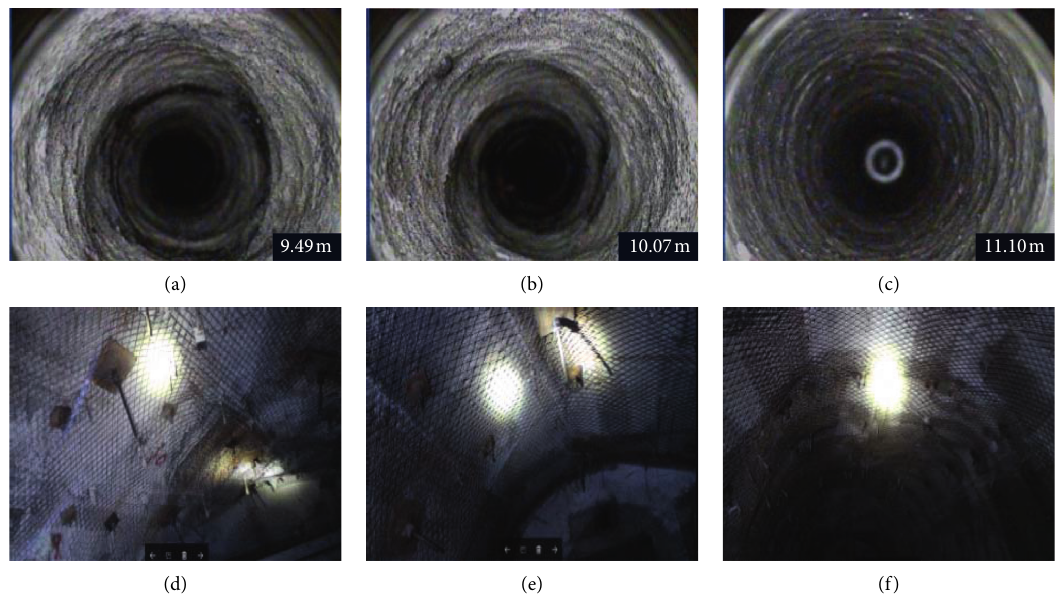
Figure 12: Photos of the project site after the completion of support. (a–c) Internal conditions after grouting. (d–f) Surface after grouting.